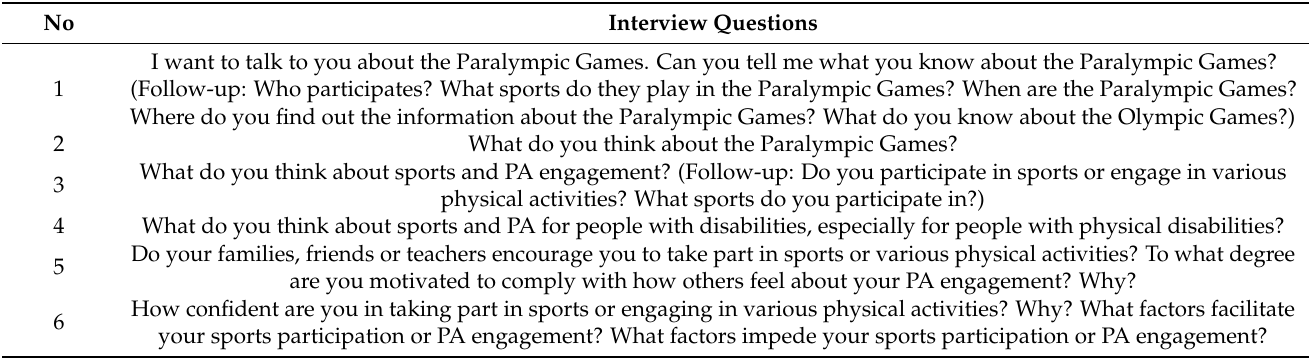
Table 1. Pre-implementation Interview Guide.